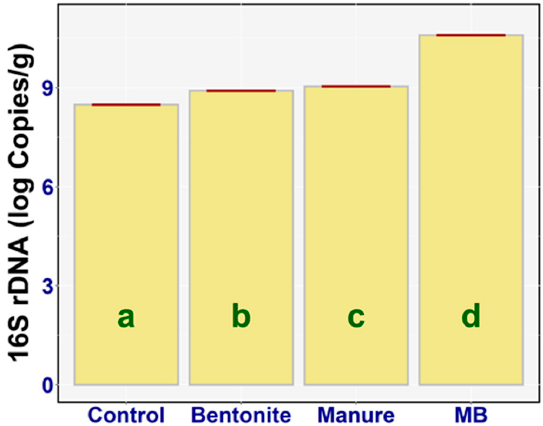
Figure 8. 16S rDNA (log Copies / g) of the treatments: means with SEM.